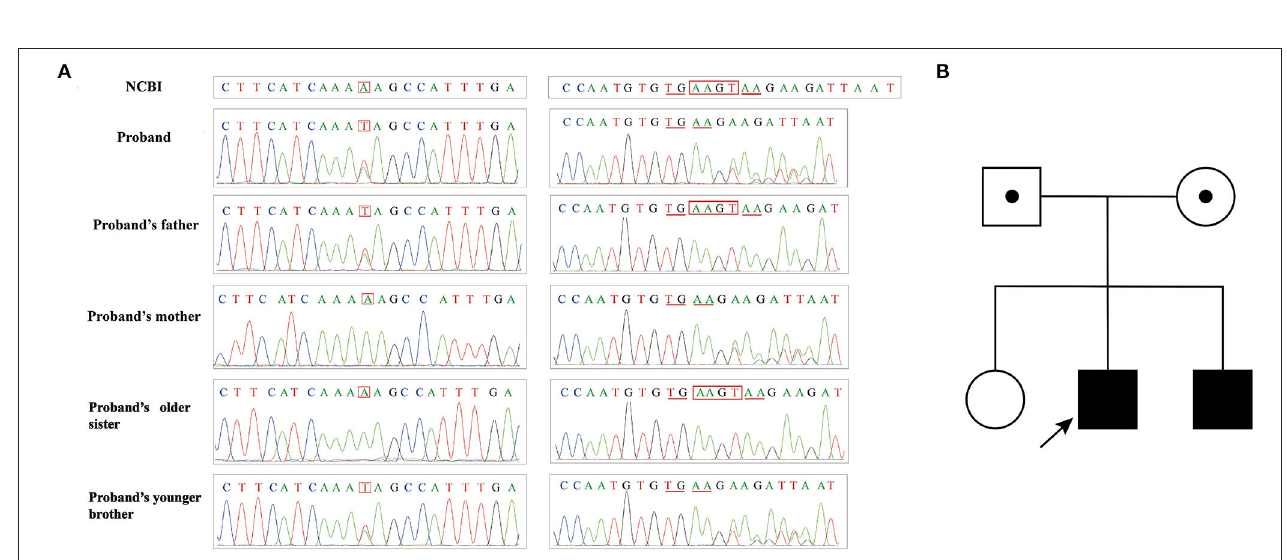
FIGURE 6 | (A) Sanger sequencing results of family III; (B) Pedigree of family